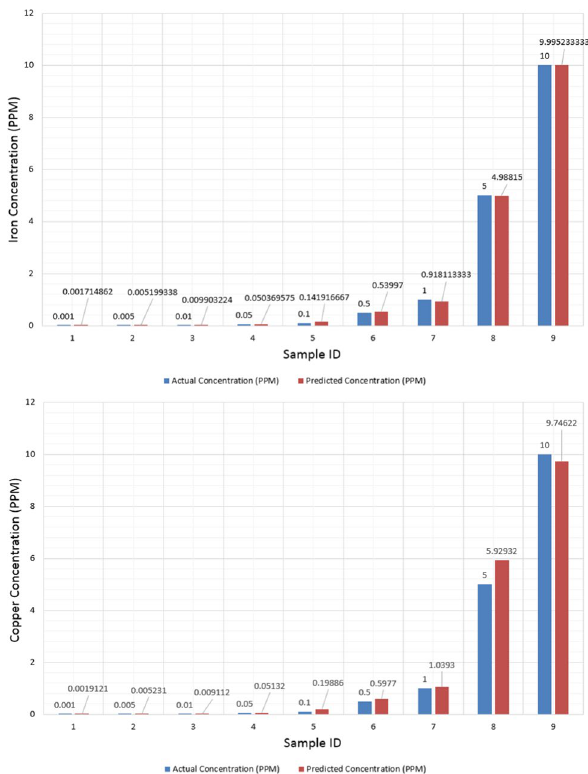
Fig. 9 Testing of developed spectrometer system with known concen- trations of copper and iron samples